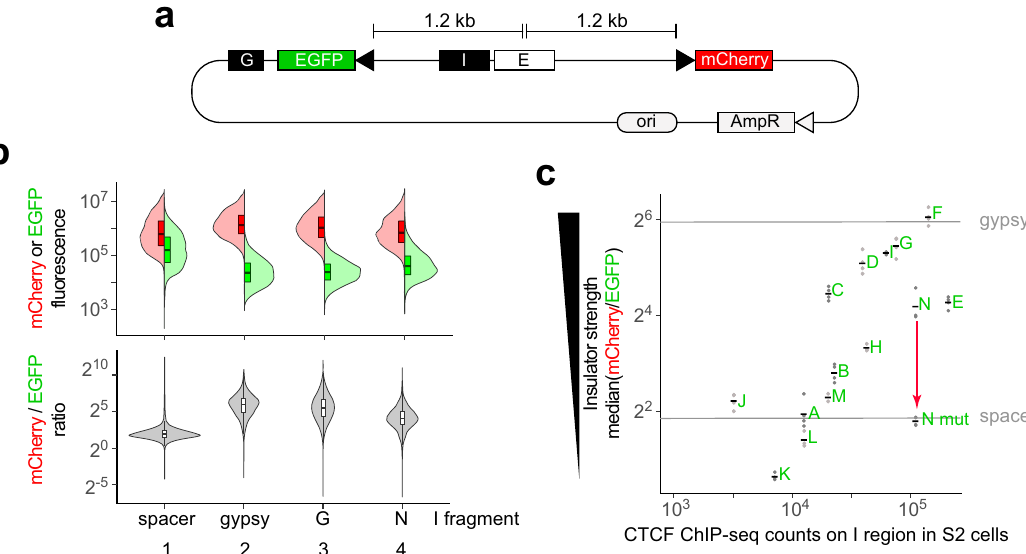
Fig. 4 CTCF occupancy scales with enhancer-blocker activity in a reporter assay. a In the reporter plasmid, a test insulator I is cloned in between an enhancer E and EGFP, and mCherry serves as a reference (elements are drawn to scale, arrowheads represent Hsp70 minimal promoters). A gypsy insulator G is present downstream of EGFP to block EGFP activation by the enhancer (which in a circular plasmid molecule is both upstream and downstream of EGFP) from the left. b Split violin plots (thick lines mark medians, boxes mark interquartile ranges) show distributions of mCherry (left) and EGFP (right) fl uorescence intensities (log 10 values in y) measured in thousands of single S2 cells transiently transfected with reporters with indicated I fragments (in x). mCherry-to-EGFP ratios (log 2 values in y) in single cells are shown below. For each reporter, merged biological triplicates are plotted. c Median mCherry- to-EGFP ratios in single transfected S2 cells (log 2 values in y) relative to CTCF ChIP-seq counts in S2 cells 42 (log 10 values in x) on selected CTCF peaks (labeled A – N, Supplementary Fig. 4c) cloned as I fragments. n = 2 (M), 3 (H, I, L, N) or 4 (A – G, J, K, N mut) biological replicates (dots) and mean values (horizontal lines) are shown. As a reference, mean values obtained with the gypsy insulator or a neutral spacer are indicated as horizontal lines. As a control, a CTCF motif in fragment N was mutated, leading to fragment N mut for which CTCF ChIP occupancy was not